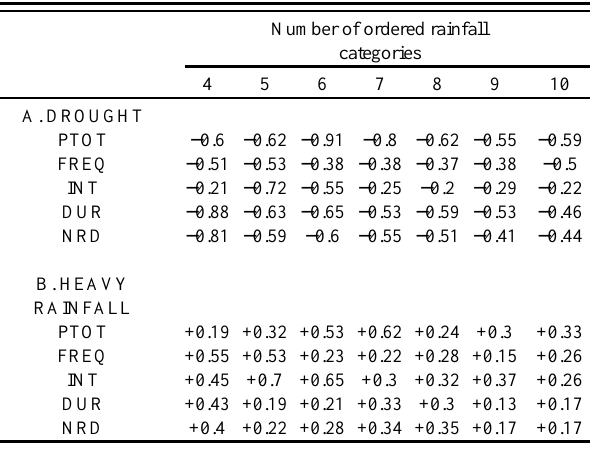
Table 2 . Association between categories of observed rainfall and Pearson’s residuals for reported drought and heavy rainfall events. For each rainfall variable, the linear correlation coefficient (r) between Pearson’s residuals and ordered rainfall categories was computed considering from 4 to 10 rainfall categories into the analysis. PTOT - seasonal precipitation amount; FREQ - frequency of rainy days; INT - rainfall intensity; DUR - seasonal duration; and NRD - number of rainy